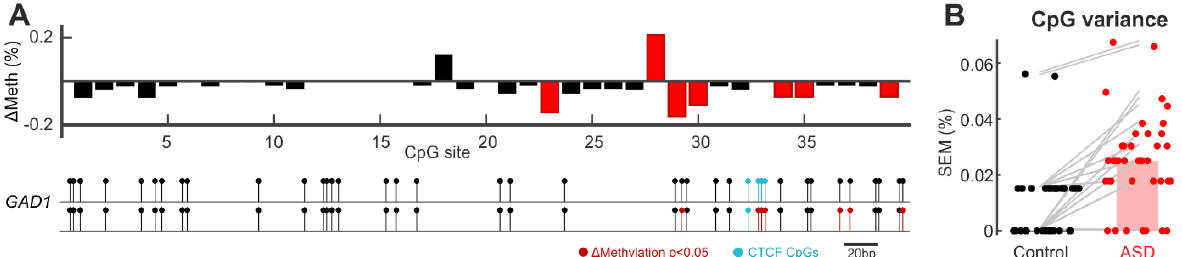
Figure 4. ( A ) Upper: CpG-wise differential methylation across the profiled GAD1 region of interest. Differential methylation plotted as (average percentage methylation in ASD group) minus (average percentage methylation in control group) for each CpG site, such that positive values reflect hyper- methylation in ASD relative to controls. N = 56 clones from ASD group; 66 clones from control group. Red bars: p < 0.05 Wilcoxon signed rank. Lower: CpG sites in the profiled GAD1 amplicon mapped onto the human genome. ( B ) Increased CpG methylation variance in ASD. Bar height: Median variance (SEM) at each CpG site (N = 39 CpG sites, p < 0.05 Wilcoxon rank sum. Note: Median variance for control group is 0). Grey: Corresponding variance between control and ASD at each CpG